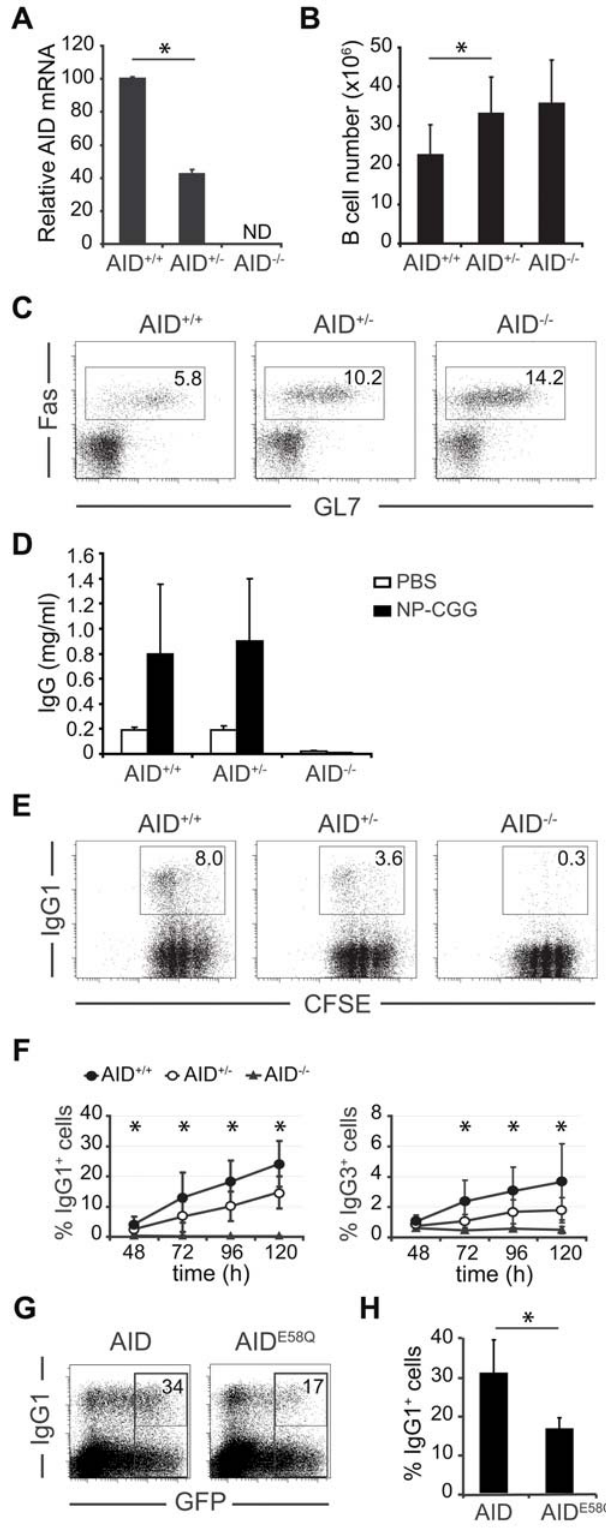
Figure 1. AID is haploinsufficient for CSR. (A) AID levels are reduced in AID + / 2 mice. Spleen B cells from AID + / + , AID + / 2 and AID 2 / 2 were stimulated for 3 days in the presence of LPS and IL4. RNA was isolated and AID expression was assessed by real-time RT-PCR. Bars represent AID mRNA expression relative to AID + / + B cells. Statistical